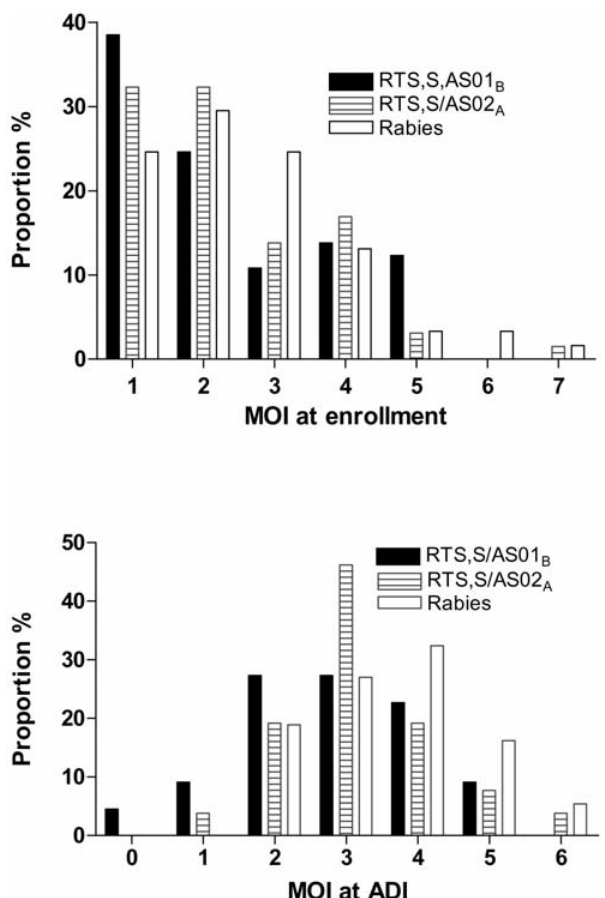
Figure 2. Multiplicity of infections at enrollment and during active detection of infection. Minimum number of clones for vaccine and control groups at enrollment and during the active detection of infection (ADI) period. At enrollment, denominators were n=65 for RTS,S/AS01 B , 65 for RTS,S/AS02 A and 61 for rabies. During the ADI period, the denominators were n=22 for RTS,S/AS01 B , n=26 for RTS,S/AS02 A and n=37 for rabies.